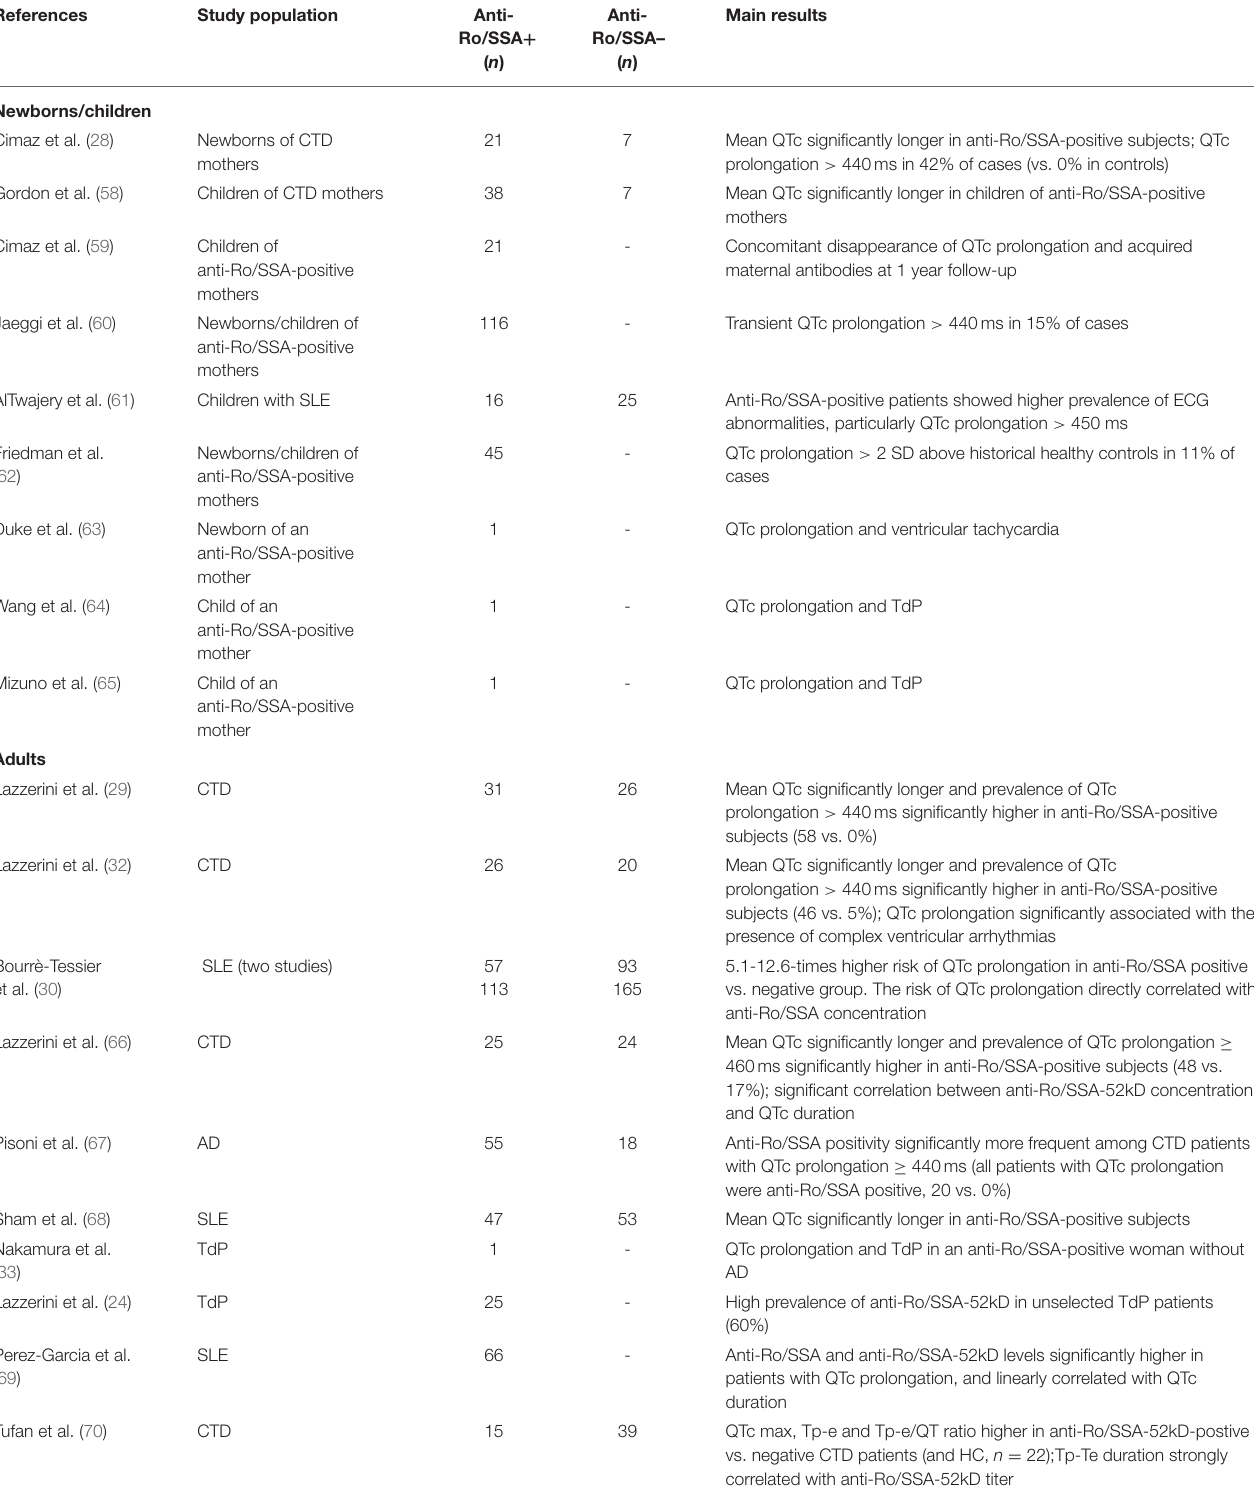
TABLE 1 | Clinical studies showing an association between anti-Ro/SSA antibodies and